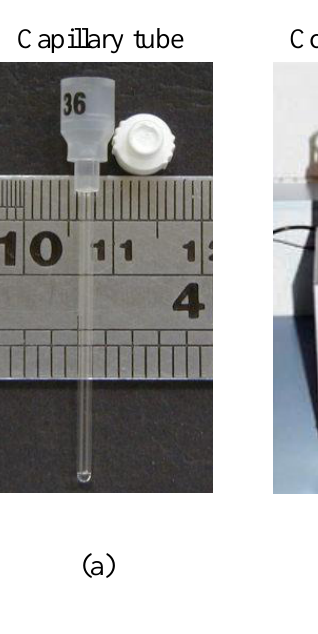
Figure 1 Schematic view of the fluorescence sensing system of the commercial real-time PCR